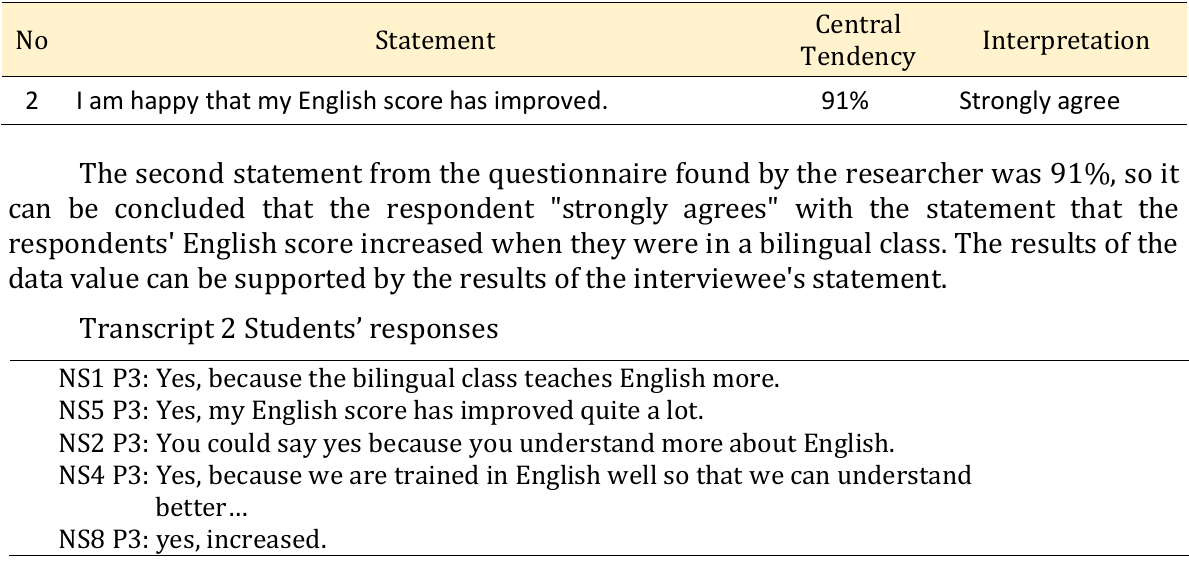
Table 2. Statement 2 questionnaire and interview data